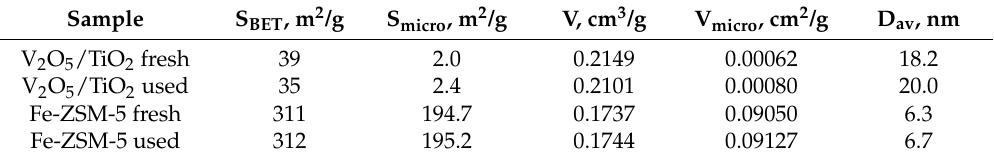
Table 1. Total and micropore surface areas, S BET and S micro , total and microporous pore volumes, V and V micro , average pore size, D av , and values of fresh and used catalysts.